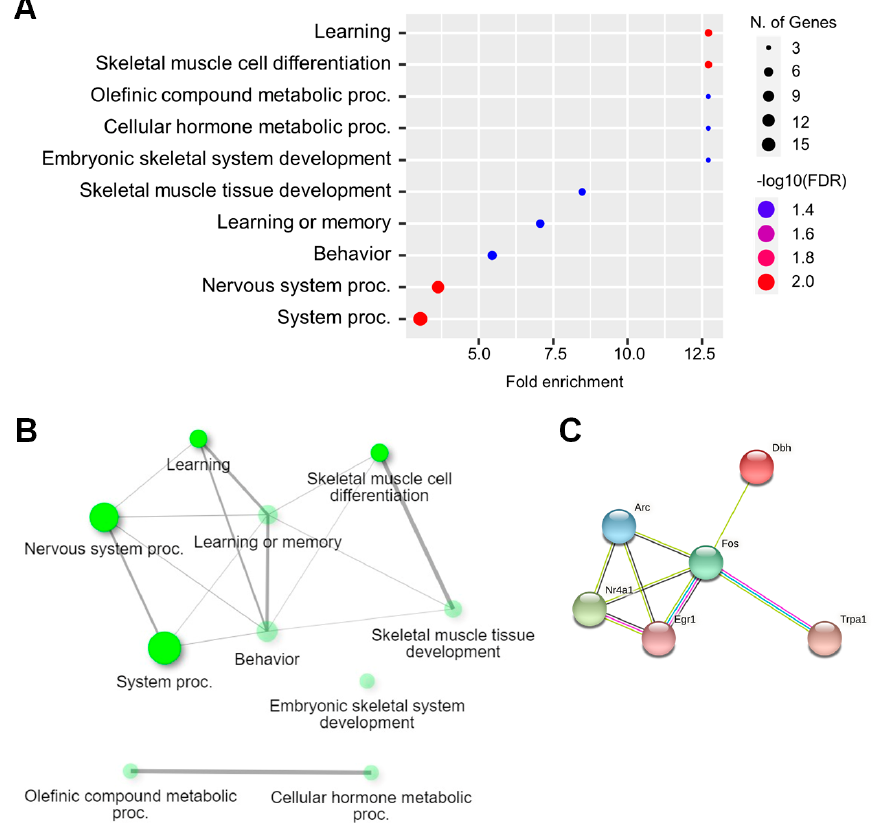
Figure 2. Gene ontology (GO) analysis of downregulated genes from the RNA-seq data. ( A ) Dot plot of enriched genes under GOBP (top ten) in EAE-affected hippocampi with > − 1.5-fold change and p- value < 0.05. ( B ) Interactive plot showing the relationship between enriched pathways. ( C ) STRING analysis of the top ten pathway genes in GOBP at a medium confidence level (0.4).